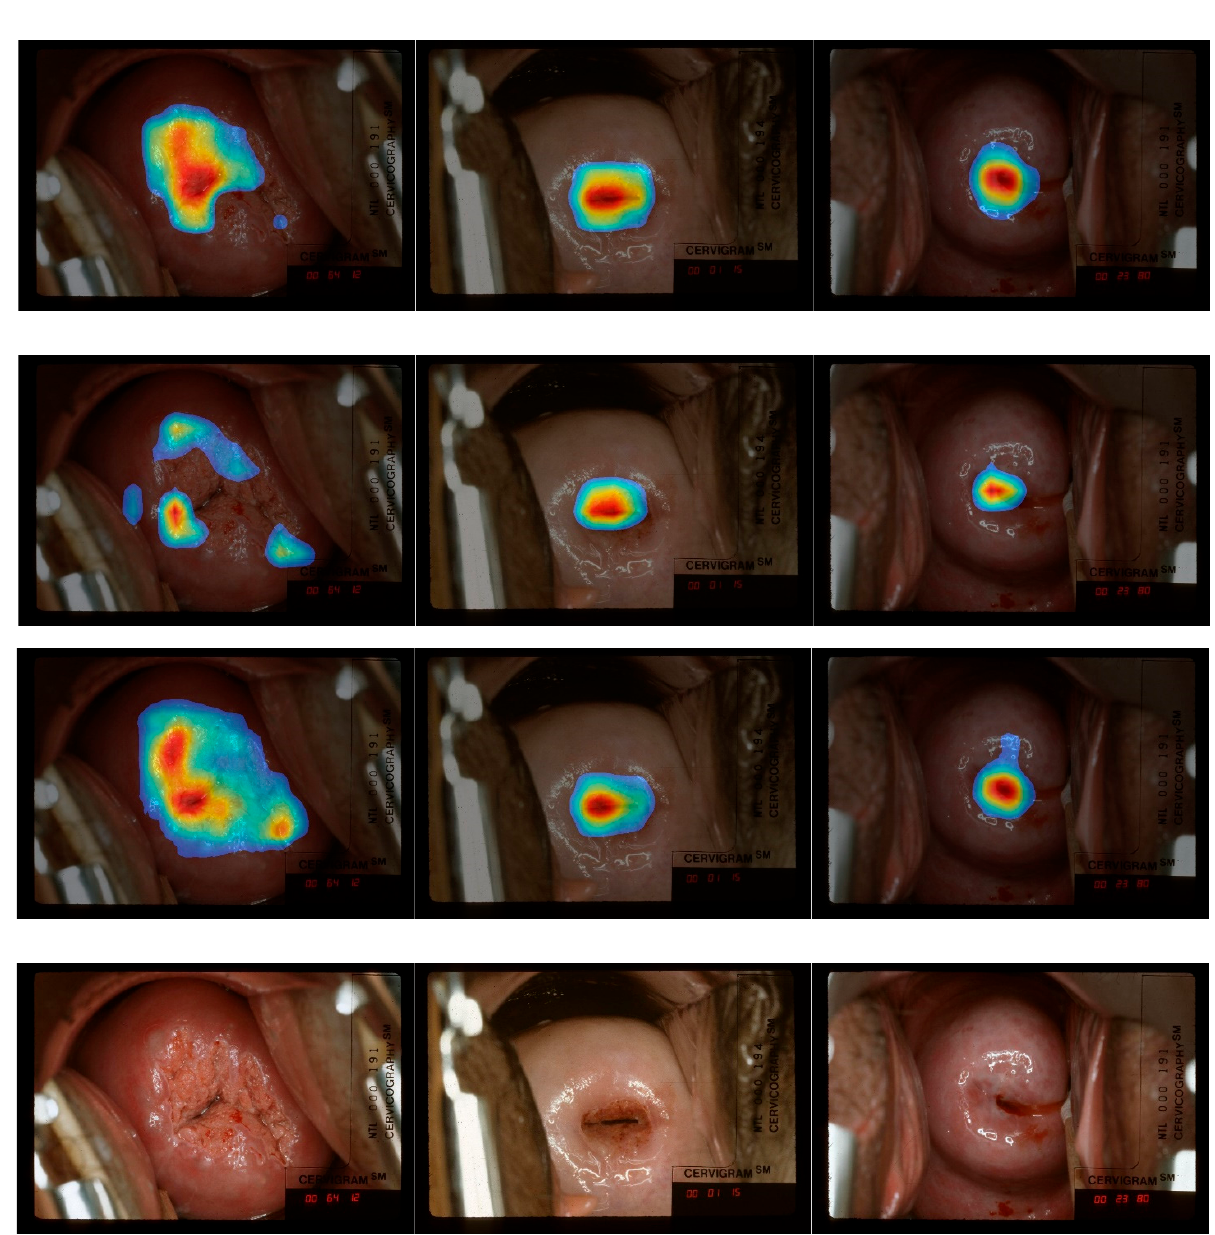
Figure 4. Example of Class-selective Relevance Map (CRM) heatmap images generated from the fine-tuned classification model. The heatmaps in the 1st row are generated from the classification model built with Concatenate ( P 3 , P 6 , P 7 ) as the last convolutional layer. The heatmaps in the 2nd row are generated from the classification model built with P 6 as the last convolutional layer. The heatmaps in the 3rd row are generated from the classification model built with Concatenate ( P 3, P 4, P 5, P 6, P 7 ) as the last convolutional layer. The bottom row images are without any heatmap displayed.